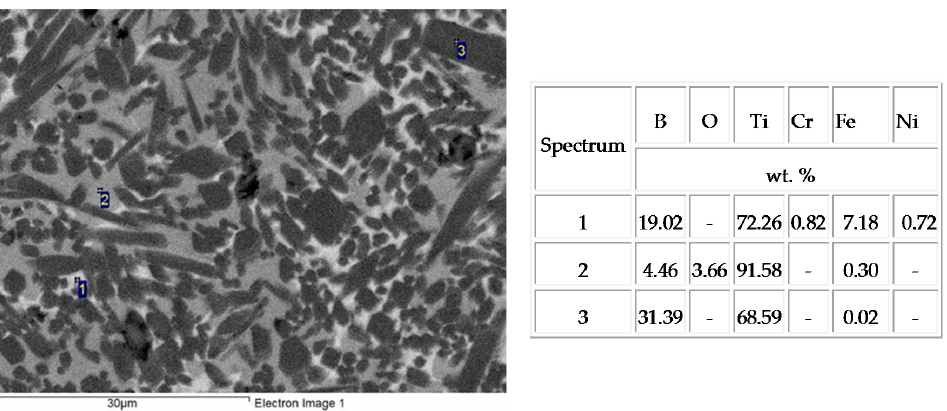
Figure 3. Microstructure and the results of energy dispersive analysis of elements in the material synthesized during combustion followed by high-temperature deformation.